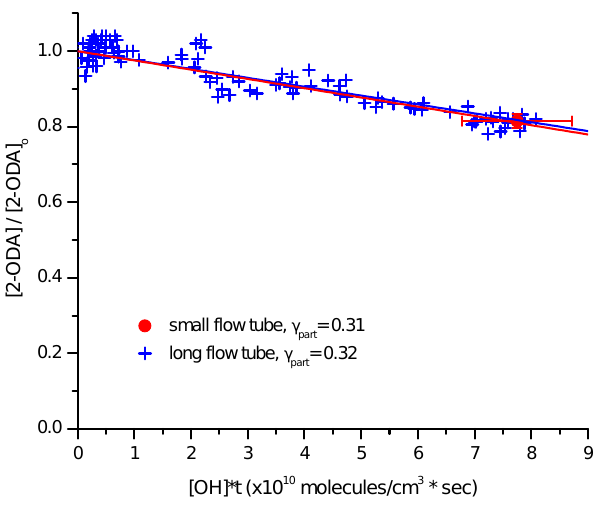
Fig. 4. 2-ODA decay from reaction with OH in the small and large flow tubes with [O 3 ] = 3–4 × 10 15 moleculescm − 3 .